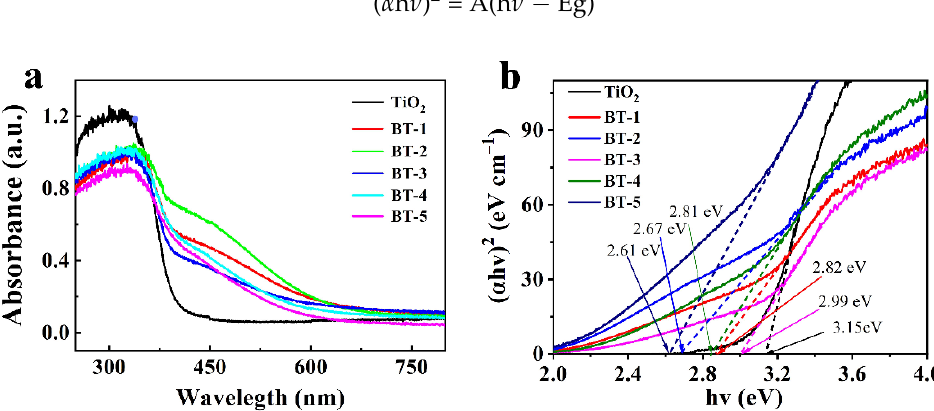
Figure 4. ( a ) UV-Vis diffuse reflectance spectra of the samples; ( b ) the bandgap values transformed by a Kubelka-Munk function. by a Kubelka-Munk function.